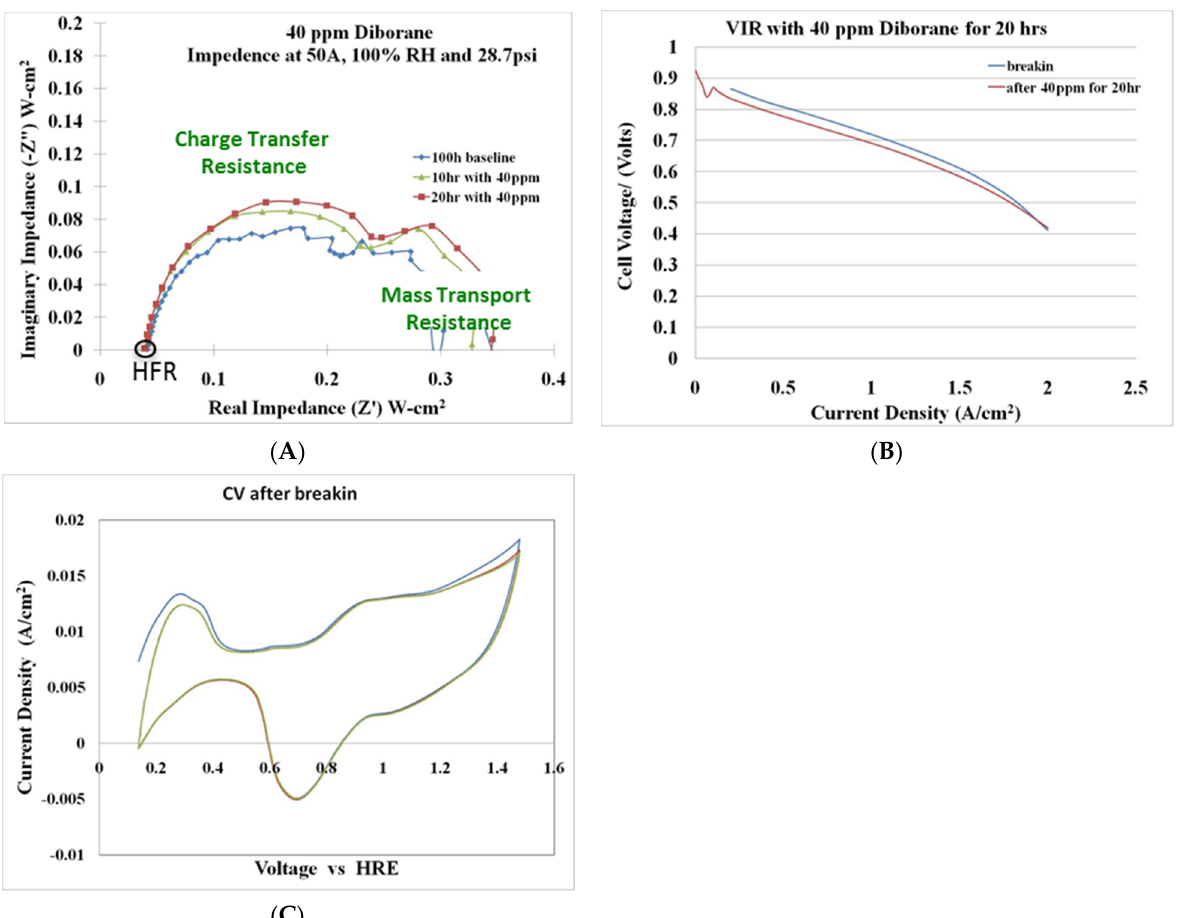
Figure 20. Fuel cell tolerance testing with 40 ppm diborane ( A ) AC impedance spectroscopy, ( B ) current-voltage-resistance (VIR) curves, and ( C ) cyclic voltammograms for a 20 h exposure test.